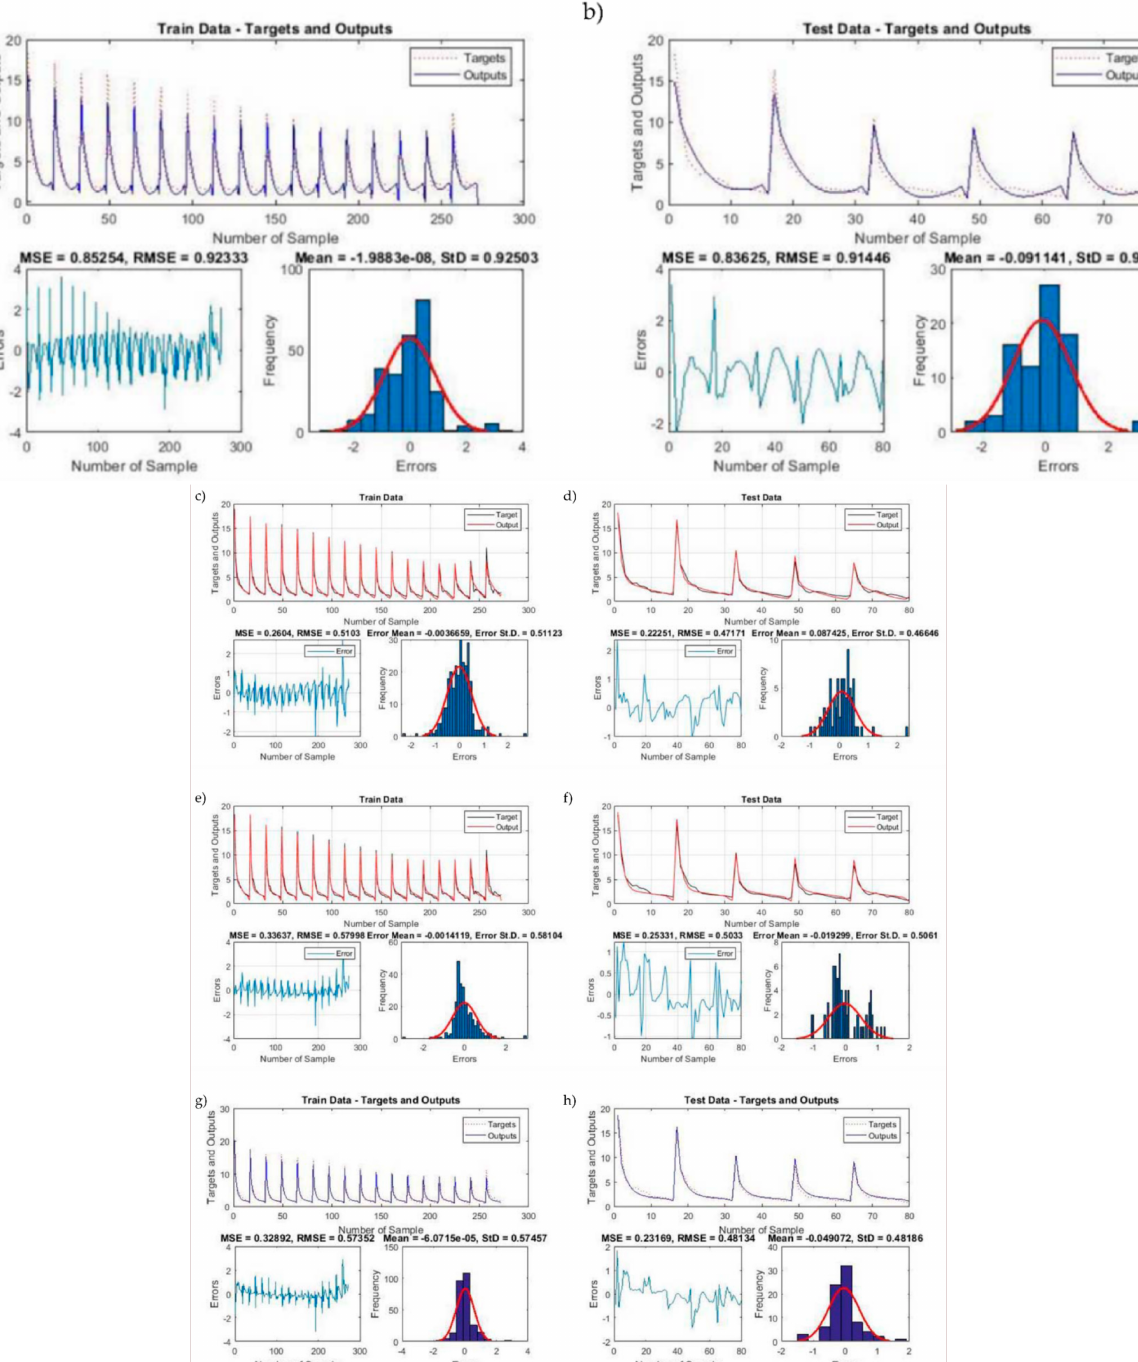
Figure 8. For output S r , ANFIS Model ( a ) targets and outputs, RMSE, MSE values and frequency vs. errors graphs for train data set ( b ) targets and outputs, RMSE, MSE values and frequency vs. errors graphs for test data set. ANFIS-GA: ( c ) targets and outputs, RMSE, MSE values and frequency vs. errors graphs for train data set ( d ) targets and outputs, RMSE, MSE values, and frequency vs. errors graphs for test data set. ANFIS-PSO: ( e ) targets and outputs, RMSE, MSE values and frequency vs. errors for train data set ( f ) targets and outputs, RMSE, MSE values, and frequency vs. errors for test data set. ANFIS-FFA: ( g ) targets and outputs, RMSE, MSE values and frequency vs. errors for train data set ( h ) targets and outputs, RMSE, MSE values, and frequency vs. errors for test data